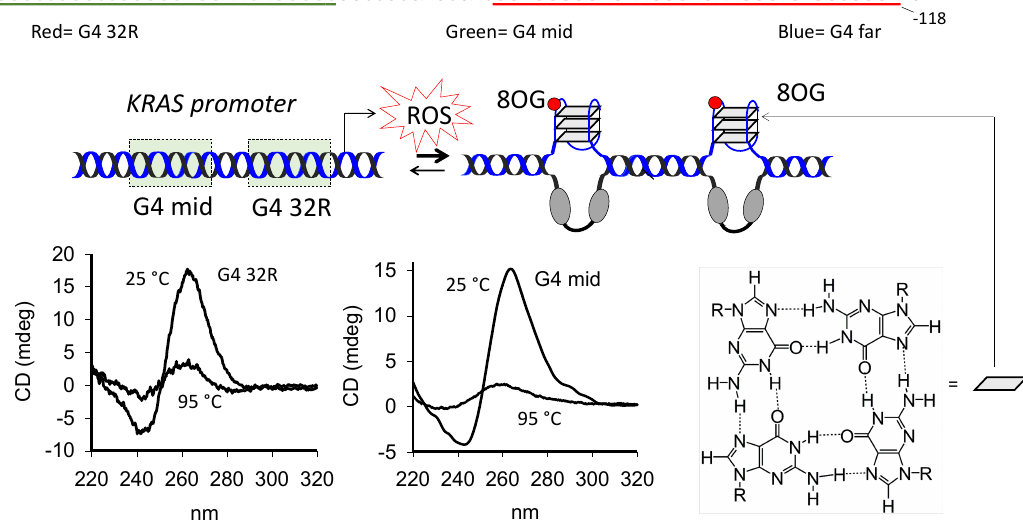
Figure 1. KRAS G4-motif sequences located upstream of the transcription start site (TSS). The G4 motifs are located in the non-coding strand between -118 and -270 from TSS: G4 32R (sequence in red, -118 / -149); G4-mid (sequence in green, -163 / -217; G4-far (sequence in blue, -229-264). G4 32R and G4 mid form G4 structures with a well-defined melting profile. The CD of these sequences (at 25 and 95 ◦ C) suggest the formation of parallel G4 structures. The structure of a G-tetrad, where each guanine forms 4 hydrogen bonds with neighboring guanines, is shown.